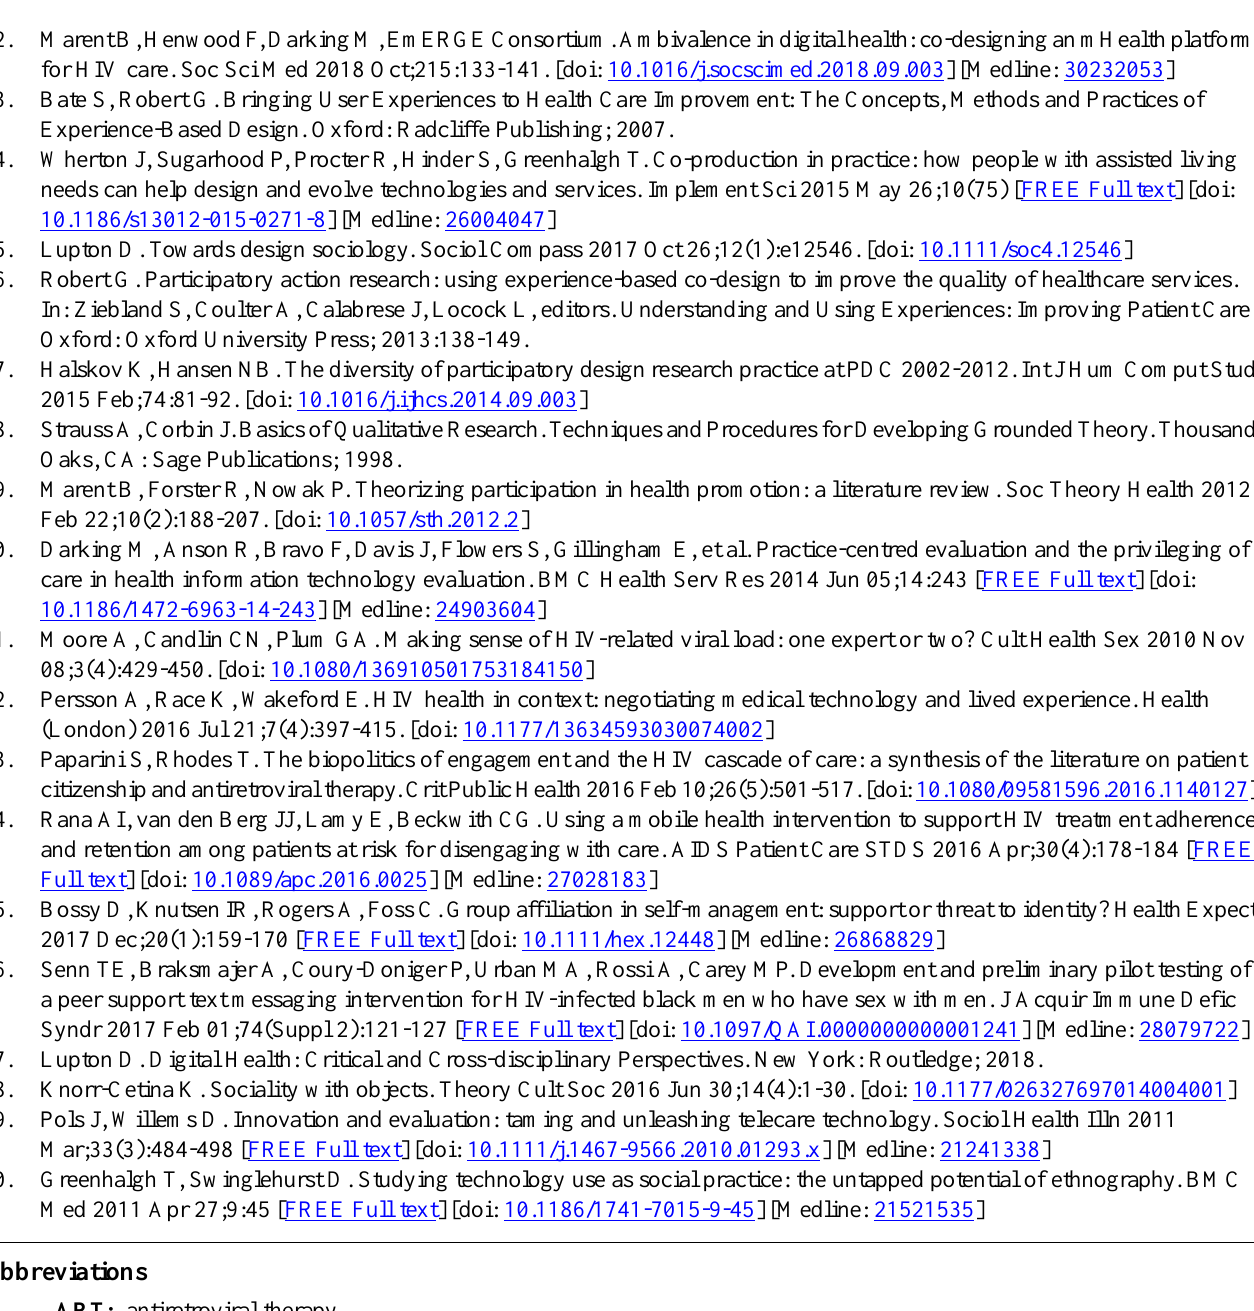
Abbreviations ART: antiretroviral therapy CD4: cluster of differentiation 4 EATG: European Aids Treatment Group EU: European Union GP: general practitioner NHS: National Health